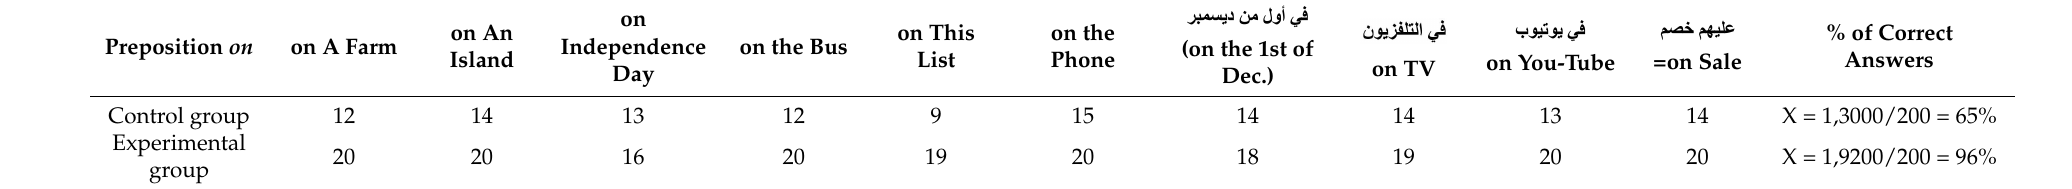
Figure 3. Pretest: percentage of correct answers regarding gender and education Table 11. Posttest 2 of the preposition on . Table 7. Posttest 1 for the preposition on . Table 7. Posttest 1 for the preposition on . Table 7. Posttest 1 for the preposition on .